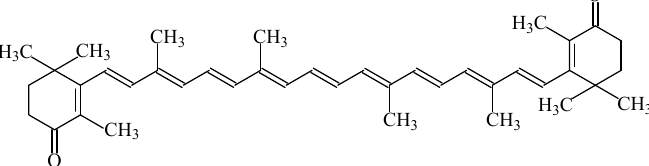
Figure 11. Canthaxanthin’s structural formula (E161g).